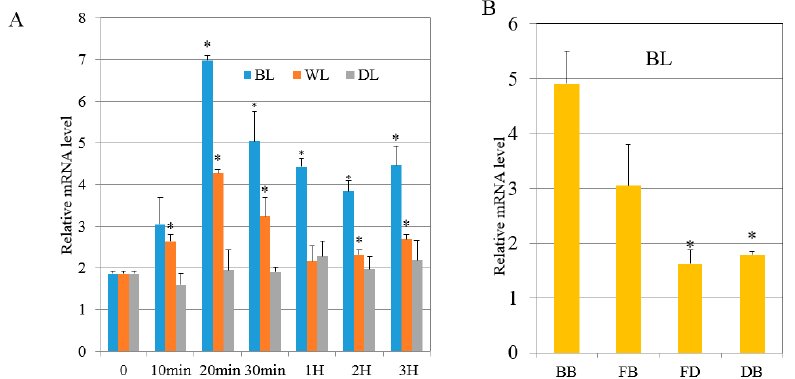
Figure 6. Expression profiling of RPS6. ( A ): The relative mRNA level of RPS6 during the time course at each light condition. ( B ): The relative mRNA level of RPS6 at different position of alga exposed to BL. BB (basal blade), FB (frond near base blade), FD (frond near distal blade) and DB (distal blade). Results are representative of three independent repeats. Error bars indicate SD ( n = 3). Asterisks denote significant difference from 0 time point as determined by t test.